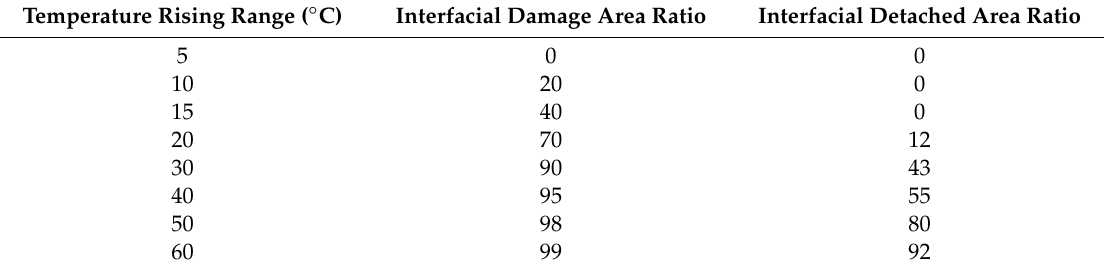
Figure 8. QUADSCRT and SDEG varying with t Table 4. Interfacial damage and detachment area ratio.